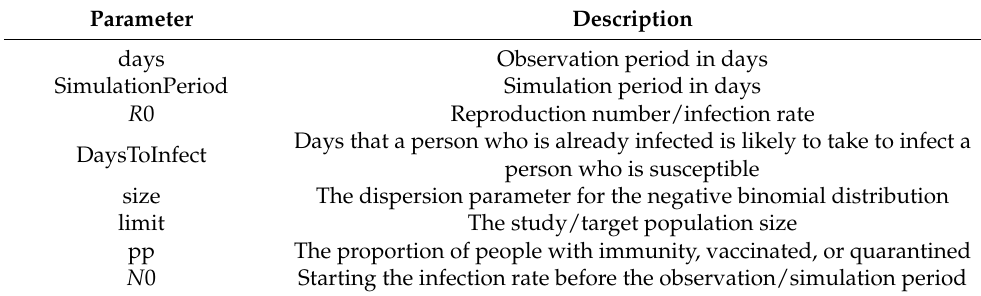
Table 2. Estimation Algorithm